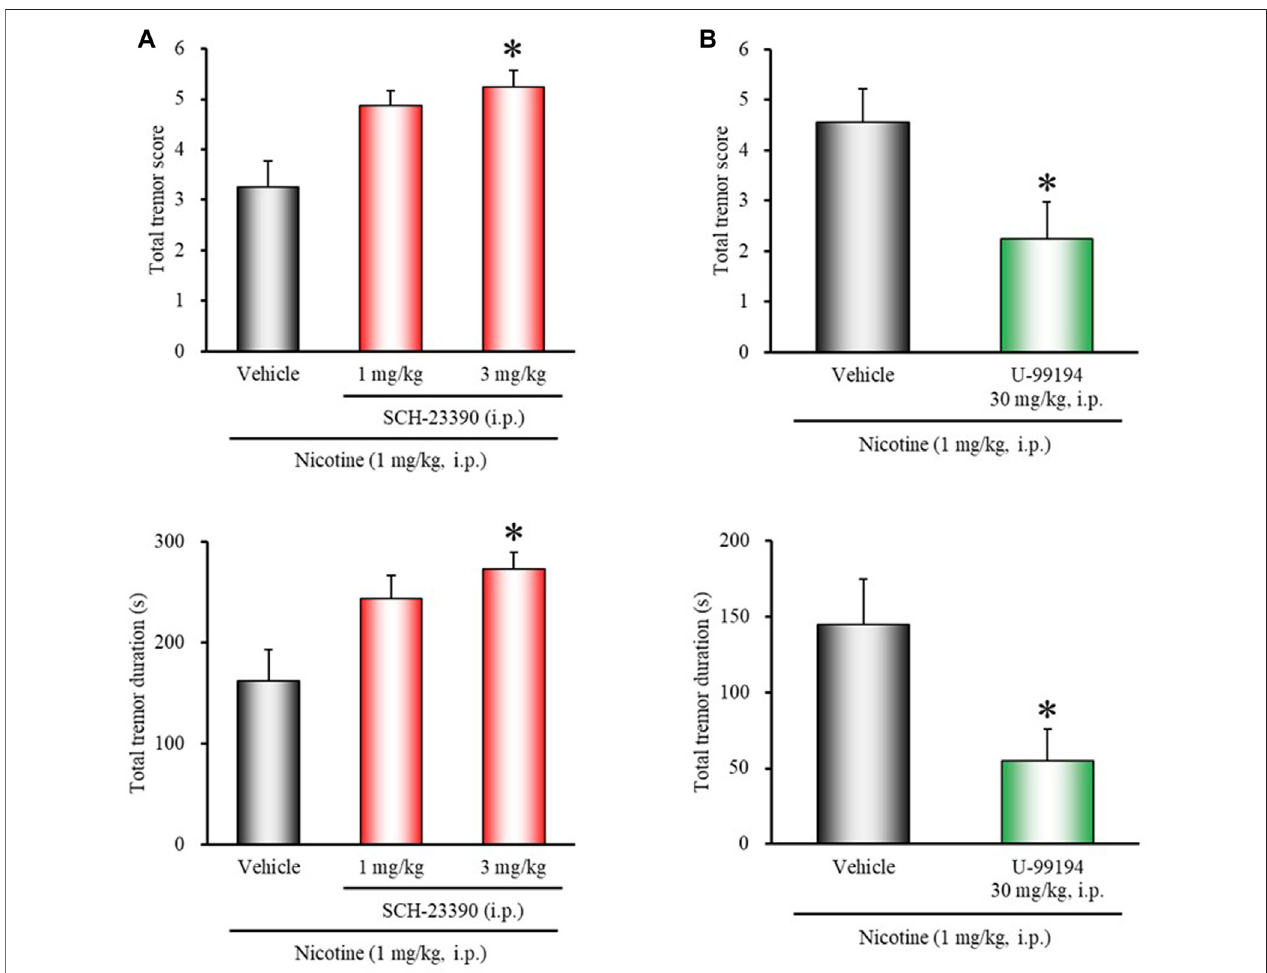
FIGURE2| Effects ofD 1/5 orD 3 receptor antagonists onnicotine-induced tremorinmice.Miceweretreatedwith: (A) theD 1/5 antagonistSCH-23390(1, 3 mg/kg, i.p.), (B) theD 3 antagonistU-99194(30 mg/kg,i.p.),orvehicle(control)15 minbeforethenicotine(1 mg/kg,i.p.)injection.Datashowthetotaltremorscore(intensity)and duration of nicotine-induced tremor over the 10 min observation period. Each column represents the mean ± S.E.M. * p < 0.05: Signi fi cantly different from control animals.